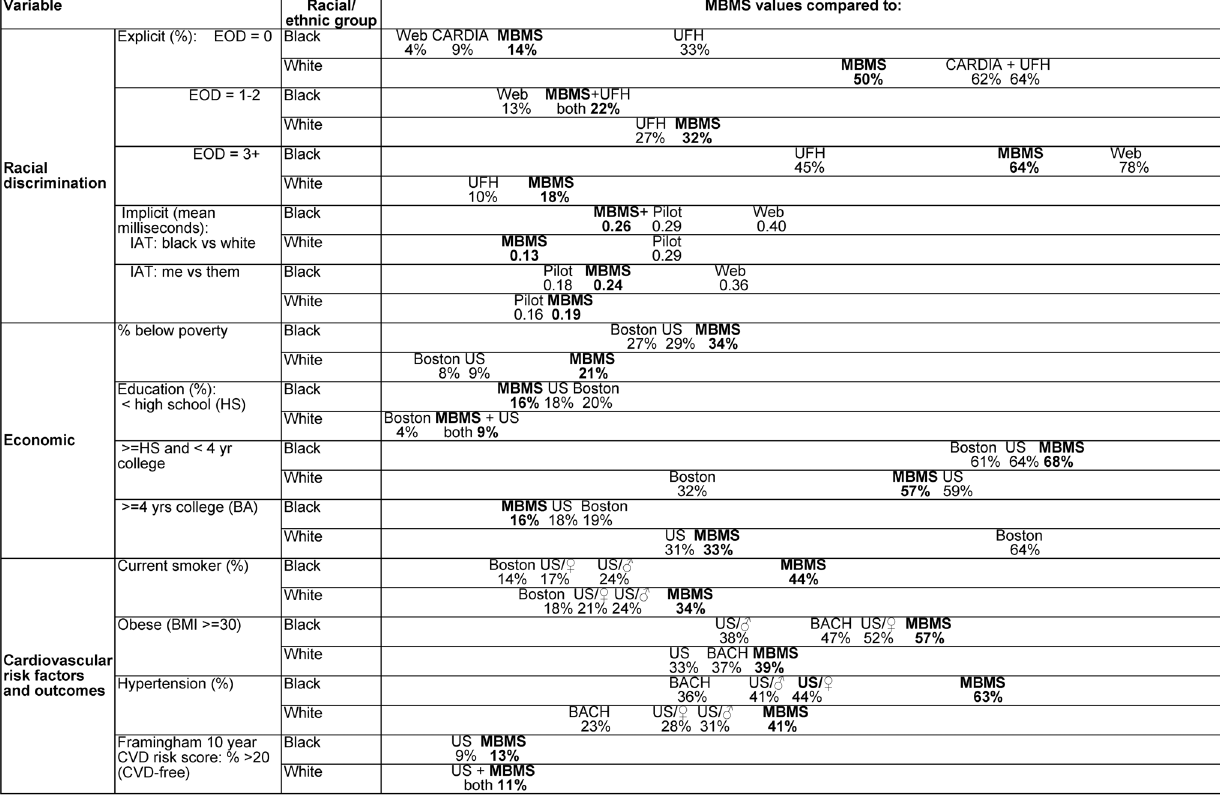
Figure 2. Distributions of average exposure to racial discrimination, socioeconomic position, and cardiovascular risk factors and outcomes, for My Body My Story participants (2008 – 2010) compared to analogous Boston data and US national data.